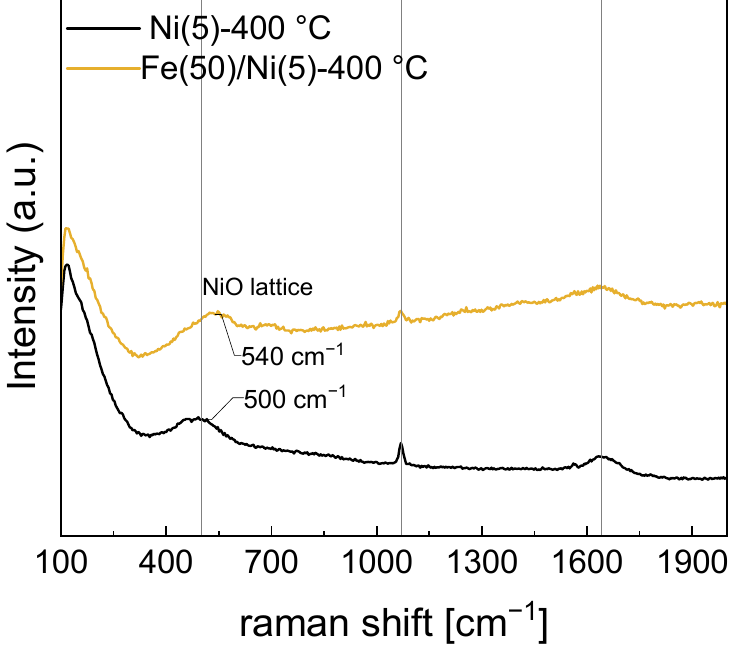
Figure 8. Raman spectra of the Ni(5)-400 °C and Fe(50)/Ni(5)-400 °C. Blue shift of the NiO-lattice mode is due to the contraction of the bond length.